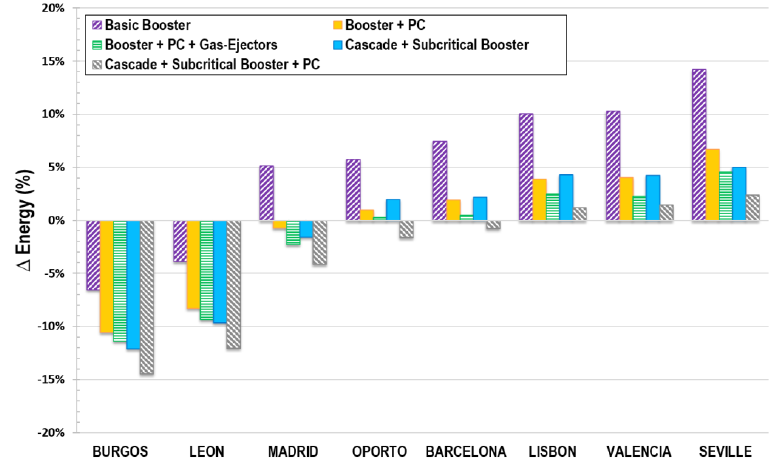
Figure 18. Energy increment with respect to R513A/R744 cascade in different cities.